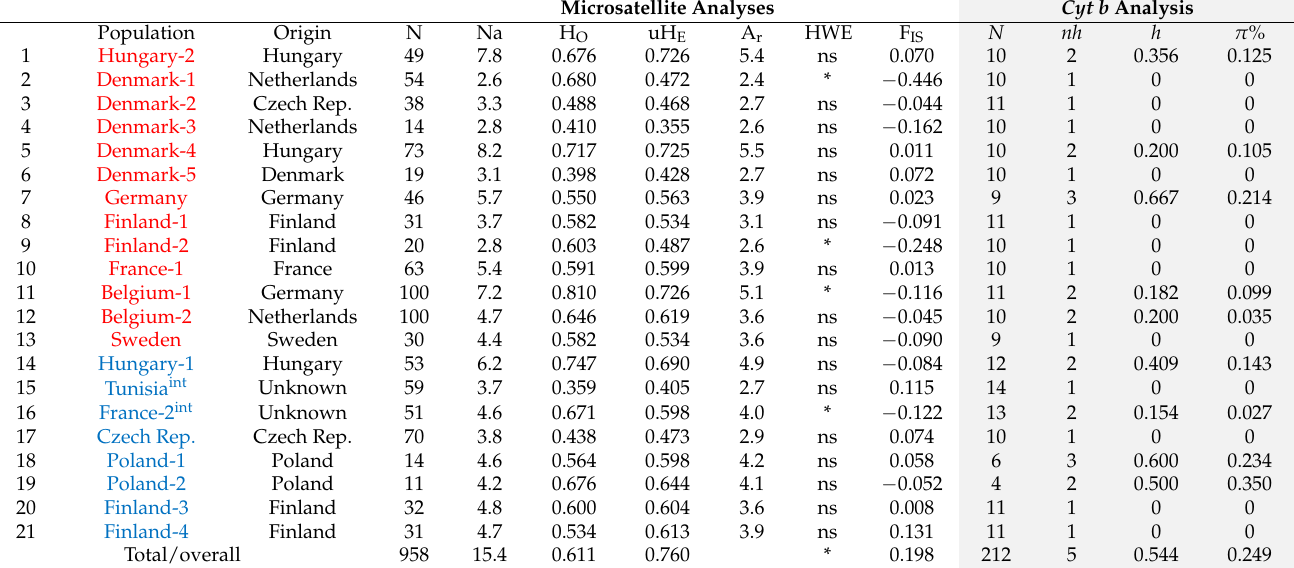
Table 1. Basic population genetic parameters of pikeperch ( Sander lucioperca ). For microsatellite loci analysis, the following are indicated: number of samples analyzed (N), mean number of alleles per locus (Na), observed (H O ) and unbiased expected heterozygosity (uH E ), allelic richness (A r ), and inbreeding coefficient (F IS ). For cytochrome b analysis, the following are indicated: number of samples analyzed ( N ), number of haplotypes ( nh ), haplotype (gene) diversity ( h ) and nucleotide diversity ( π ). Asterisks indicate significant deviations from Hardy–Weinberg equilibrium ( p < 0.05 after Bonferroni correction) . Red corresponds to domesticated and blue to wild populations. The symbol int corresponds to populations introduced out of the native species